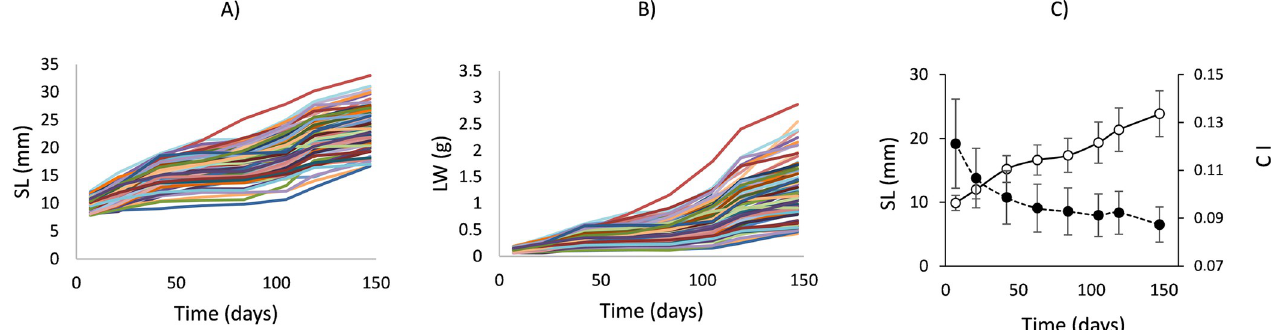
Fig 1. Growth trends of mussels ( Mytilus galloprovincialis ) from Group 1 during the maintenance period, given in terms of: A) Shell length (SL: mm) and B) Live weight (LW: g); C) mean values of shell length (hollow symbols) and condition index (CI: LW / SL 3 ) (full symbols). Bars represent ± SE.